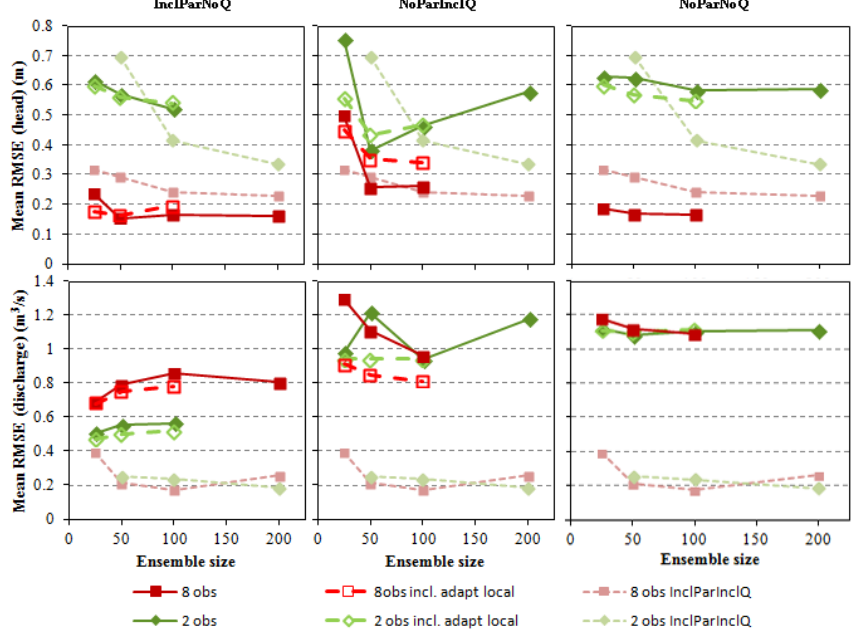
Figure 8. Head RMSE (top) and discharge RMSE (bottom) as a function of ensemble size for three of the scenarios. For comparison, the dashed lines indicate the head and discharge RMSE of the InclParInclQ scenario (without